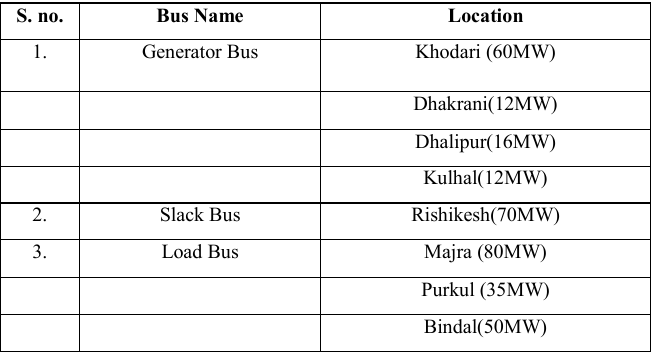
TABLE 4. OVERALL ECONOMIC INDEX (E i ) WITH ALL AVAILABLE ROUTES S.n.